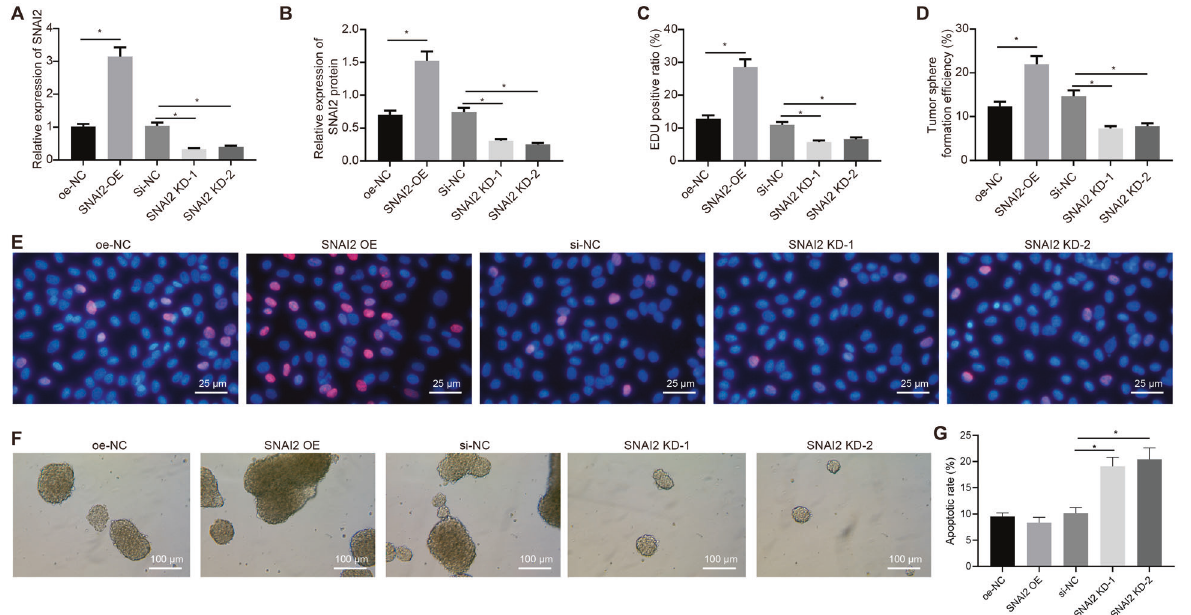
Fig. 3 SNAI2 promotes the proliferation of GSCs. A The overexpression and knockdown ef fi ciency of SNAI2 in GSCs validated with RT-qPCR. B The overexpression and knockdown ef fi ciency of SNAI2 in GSCs as detected by Western blot assay. C Statistics of EdU-positive cells in GSCs. D Statistics of cell sphere formation ef fi ciency of GSCs. E The proliferation of GSCs in response to oe-NC, oe-SNAI2, si-NC or SNAI2-KD as detected by EdU assay. F The sphere-forming ability of GSCs in response to oe-NC, oe-SNAI2, si-NC or SNAI2-KD as examined by spheroid formation assay. G the apoptosis of GSCs in response to oe-NC, oe-SNAI2, si-NC, or SNAI2-KD as examined by fl ow cytometry. * p < 0.05 vs. GSCs treated with oe-NC or si-NC. Each cell experiment was repeated three times